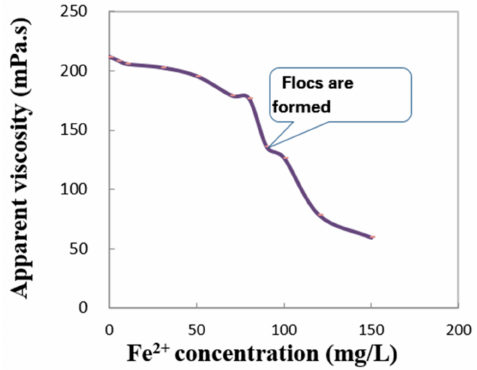
Figure 12. Fe 2+ concentration versus apparent viscosity.